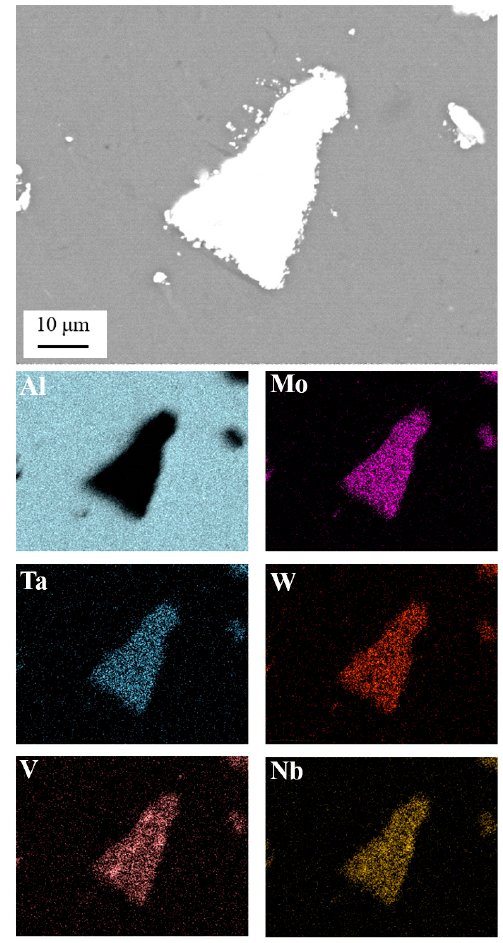
Figure 3. Microstructure of the produced composites (Back scattered electron mode): ( a ) Al ‐ 1 vol% HEA, ( b ) Al ‐ 3 vol% HEA, and ( c ) Al ‐ 5 vol% HEA.